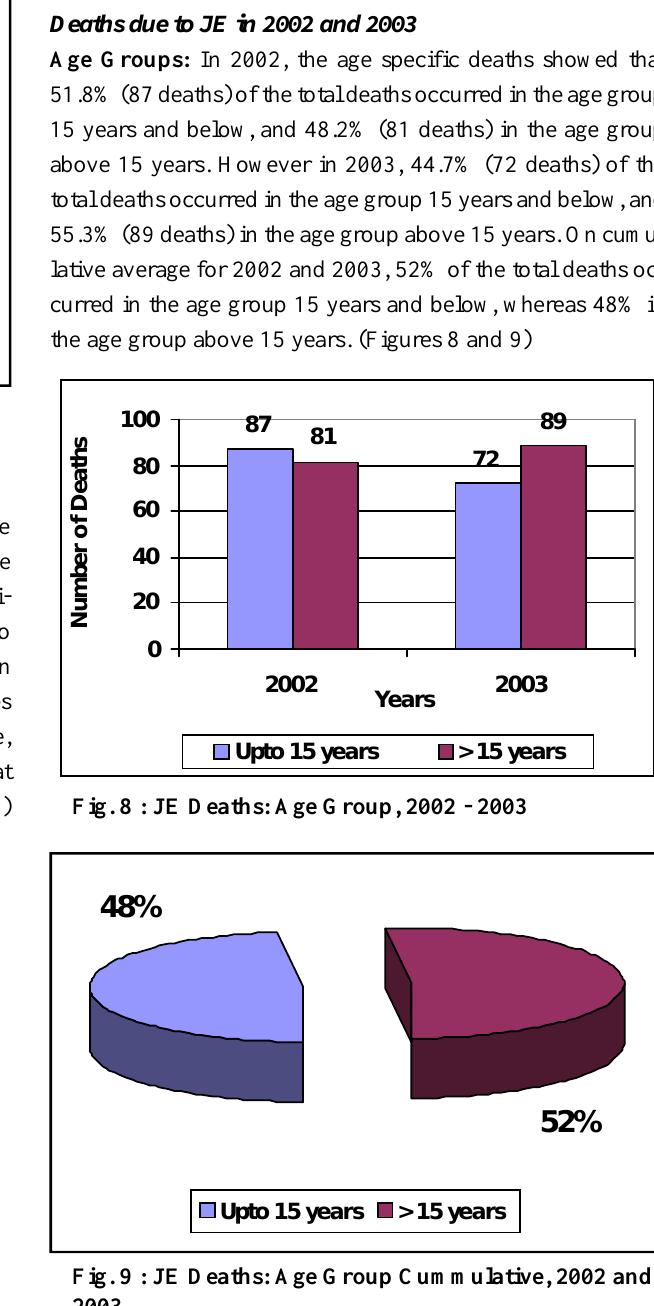
Fig. 9 : JE Deaths: Age Group Cummulative, 2002